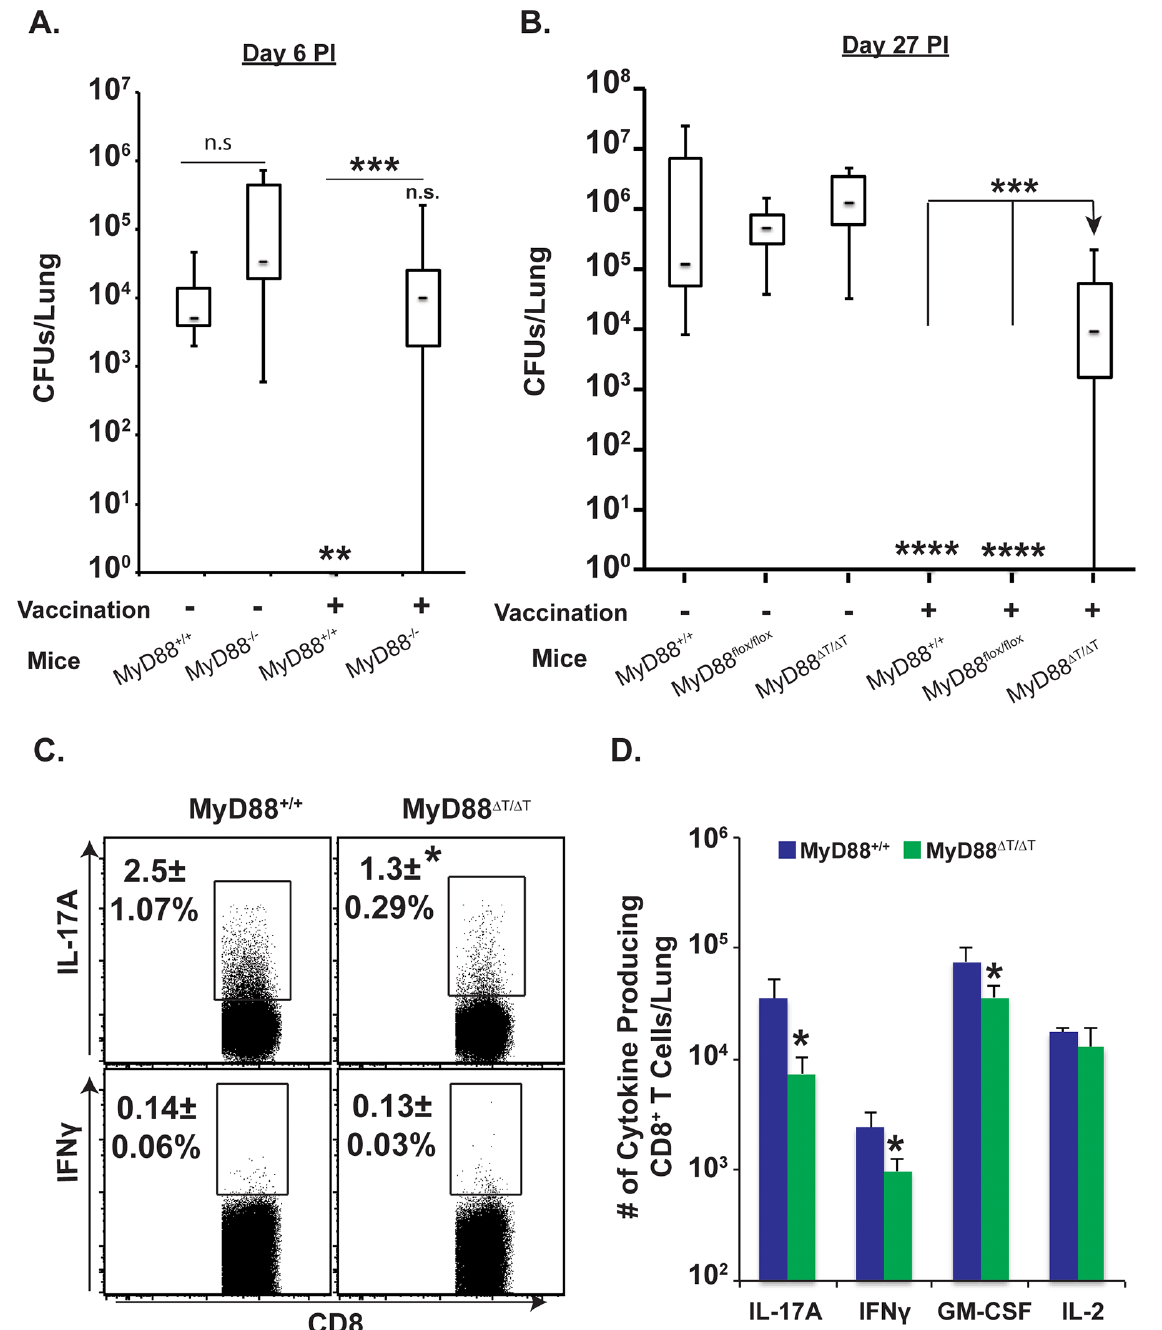
Fig 2. Intrinsic MyD88 signaling in CD8 T cells is required for vaccine immunity. (A & B) CD4 + T-cell depleted na ï ve mice were vaccinated with live (A) or heat-killed (B) #55 yeast (B). Vaccinated mice were challenged with virulent #26199 yeast, lungs were harvested for CFU analysis on indicated days, and data are shown in whisker plots (A & B ; N = 7 – 14 mice/group). Lungs were harvested 4 days post-challenge to enumerate percentage (C) and total number of cytokine-producing CD8 + T cells (D) by flow cytometry. CD4 + T cells were depleted throughout experiment. Values are the mean ± SD of 5 mice/group. * p (cid:1) 0.05, ** p (cid:1) 0.01, *** p (cid:1) 0.001 and **** p (cid:1) 0.0001. Data is representative of 2 independent experiments.